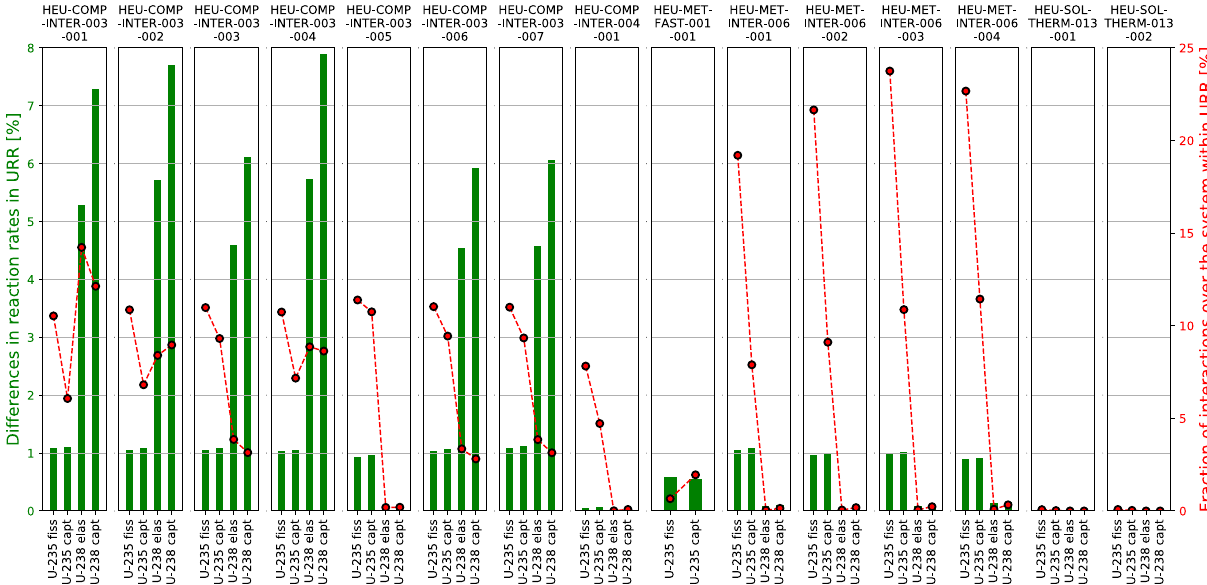
Figure 1. Differences in reaction rates in the URR with and without PT and fraction of interactions within the URR for HEU benchmarks. Relative values computed as (rr noPT – rr PT )/rr PT